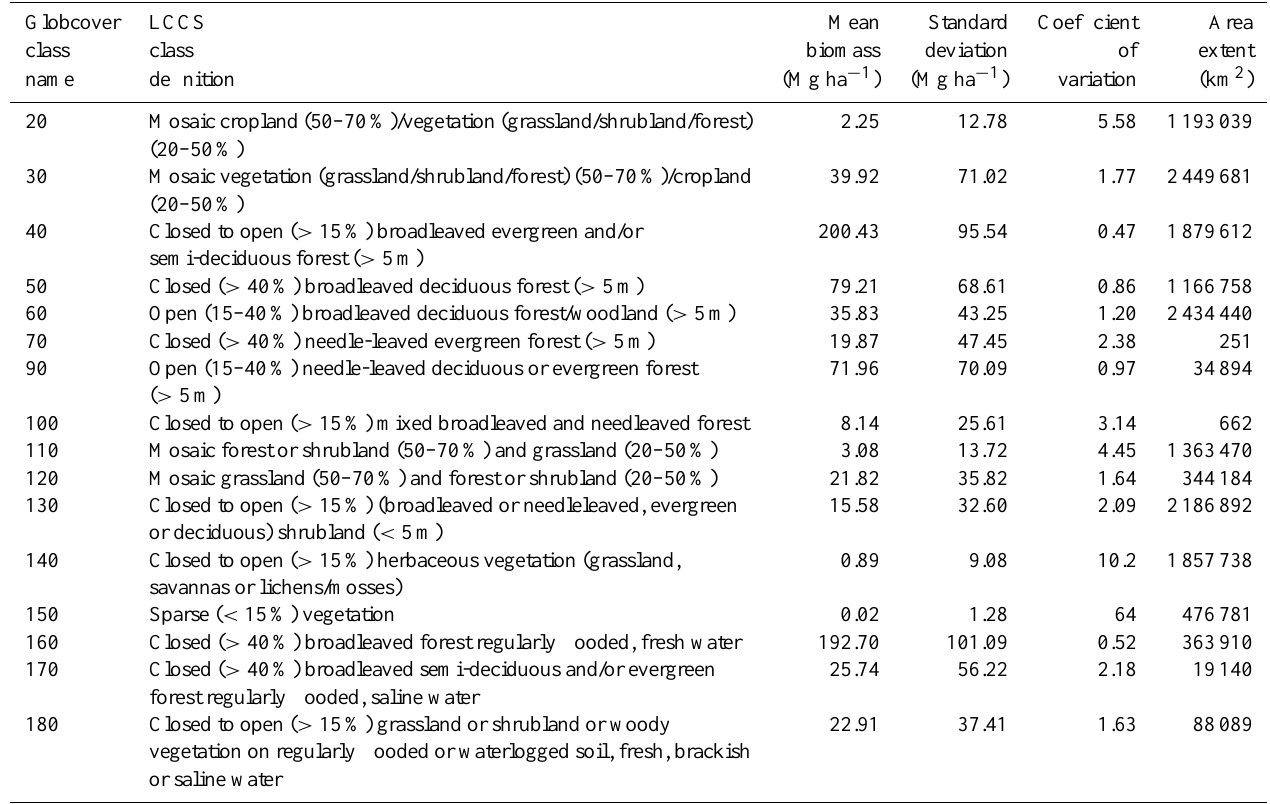
Table 3. Biomass statistics and extent according to GlobCover 2009 land cover classes. Globcover